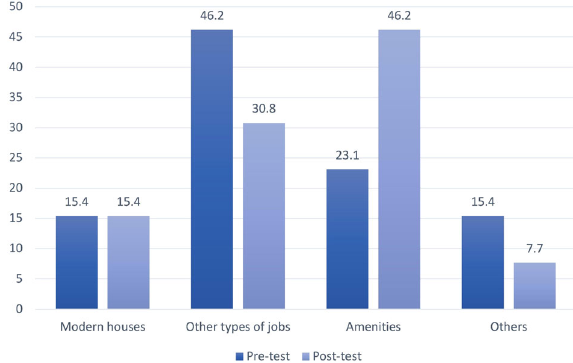
Fig. 4 School community. The most important gains after the forced